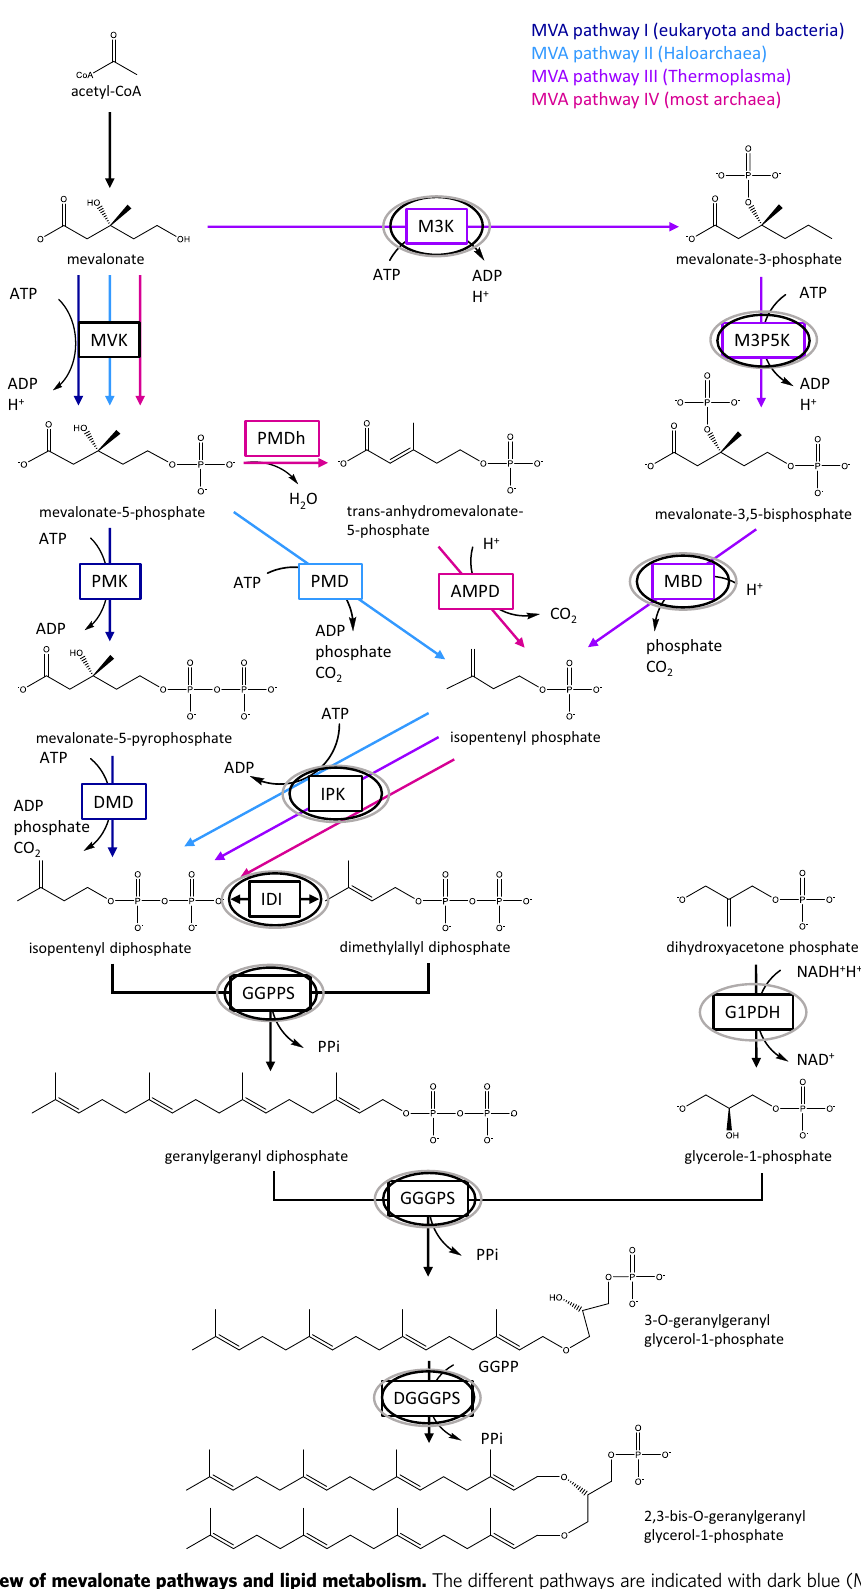
Fig. 4 Schematic overview of mevalonate pathways and lipid metabolism. The different pathways are indicated with dark blue (MVA pathway I), light blue (MVA pathway II), violet (MVA pathway III) and magenta arrows (MVA pathway IV), respectively. Names of enzymes are boxed. Enzymes expressed in Ca . Micrarchaeum harzensis and Ca . Schef fl eriplasma hospitalis are indicated with black and grey circles. Abbreviations are AMPD anhydromevalonate phosphate decarboxylase, DGGGPS 2,3-bis-O-geranylgeranyl glycerol-1-phosphate synthase, DMD diphosphomevalonate decarboxylase, GGGPS 3-O-geranylgeranyl glycerol-1-phosphate synthase, GGPP geranylgeranyl diphosphate, GGPPS geranylgeranyl diphosphate synthase, G1PDH glycerol-1-phosphate dehydrogenase, IDI isopentenyl-diphosphate-delta-isomerase, IPK isopentenyl phosphate kinase, M3K mevalonate 3-kinase, M3P5K mevalonate 3-phosphate 5-kinase, MBD mevalonate-3,5-bisphosphate-decarboxylase, MVK mevalonate kinase, PMD phosphomevalonate decarboxylase, PMK phosphomevalonate